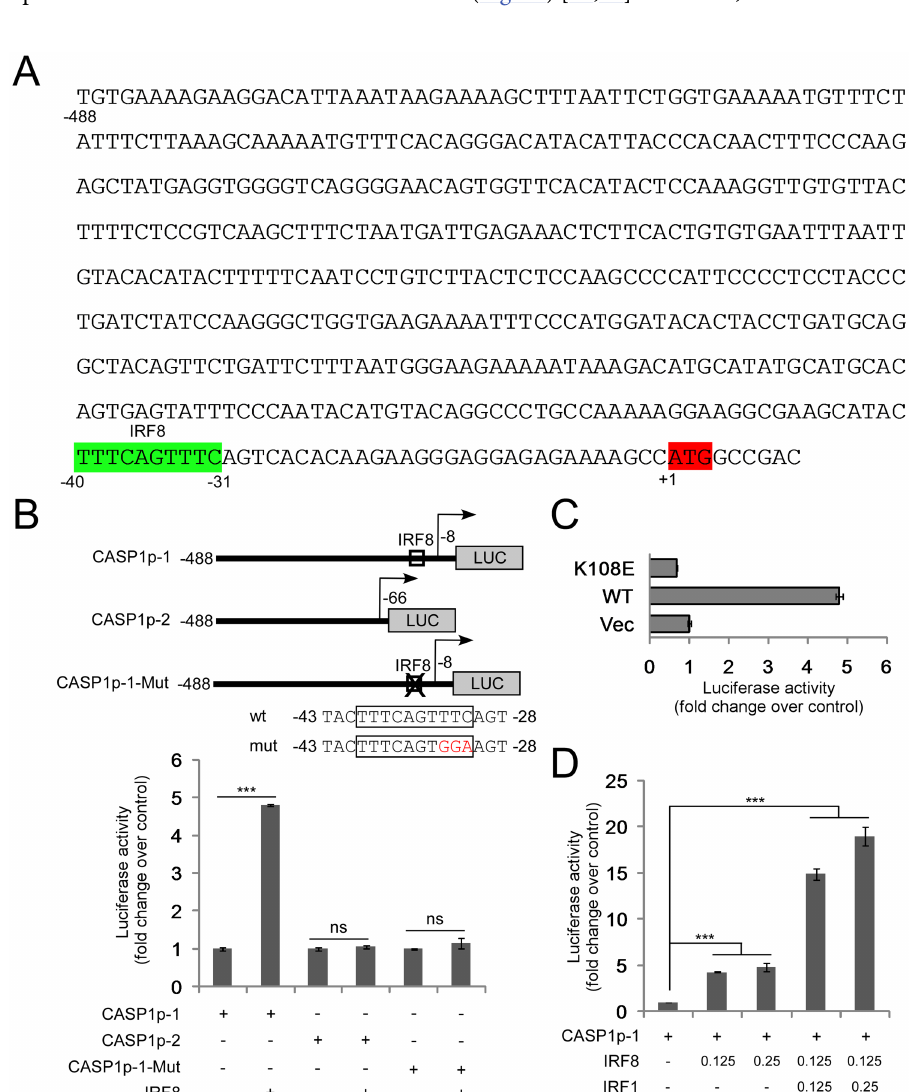
Fig 5. IRF8 regulates CASP1 promoter activities. A. Schematic representation of the promoter of human CASP1 . IRF8 consensus binding site is highlighted in green. The ATG of CASP1 is highlighted in red. B. The pGL2-CASP1p constructs (with or without IRF8 consensus site) and the IRF8 consensus site mutated construct were co-transfected into 293T cells with either vector control or IRF8 expression vectors. Luciferase assays were performed 36 hrs post- transfection. The value of cells transfected with empty vectors was set as 1. The results were presented as mean ± standard deviation of triplicate assays. C. The pGL2-CASP1p1 construct was co-transfected into 293T cells with either vector control, wild-type IRF8 (WT) or IRF8 DNA binding mutant (K108E) expression vectors and luciferase assays were performed 36 hrs post-transfection. The value of cells transfected with empty vectors was set as 1. The results were presented as mean ± standard deviation of triplicate assays. D. The pGL2-CASP1p1 construct was co- transfected into 293T cells with either vector control or IRF8 and IRF1 expression vectors and luciferase assays were performed 36 hrs post-transfection. The value of cells transfected with empty vectors was set as 1. The results were presented as mean ± standard deviation of triplicate assays. (cid:3)(cid:3)(cid:3) p <